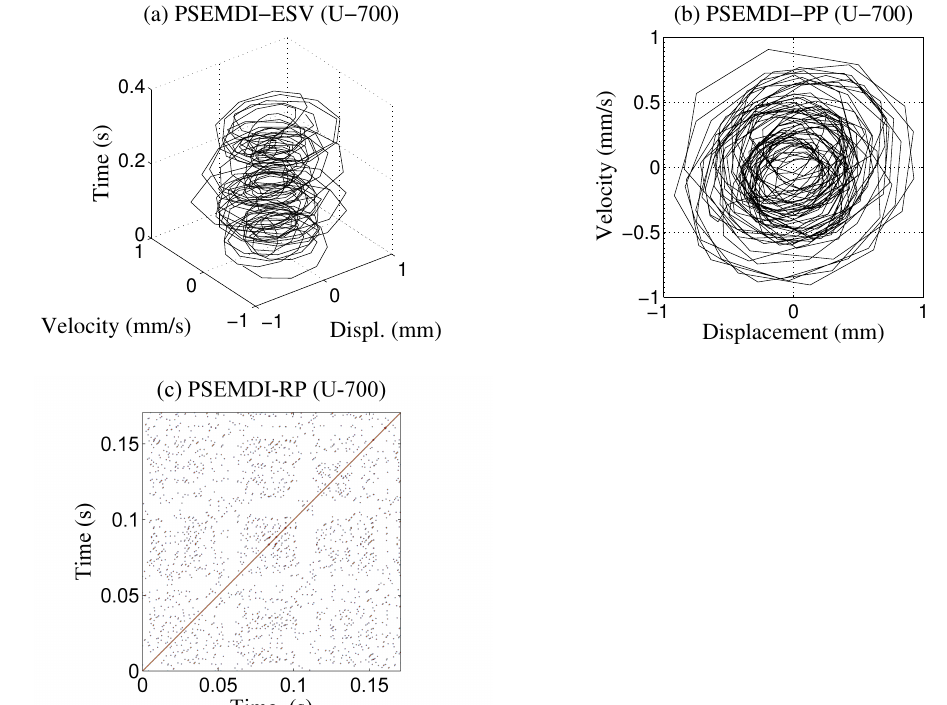
Figure 15. ( a ) Evolution of state variables; ( b ) phase plane; ( c ) recurrence plot for Case 1 at 700 rpm.